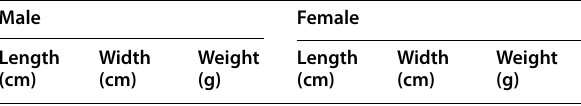
Table 1 Growth parameters of reared adult Coiblemmus compactus